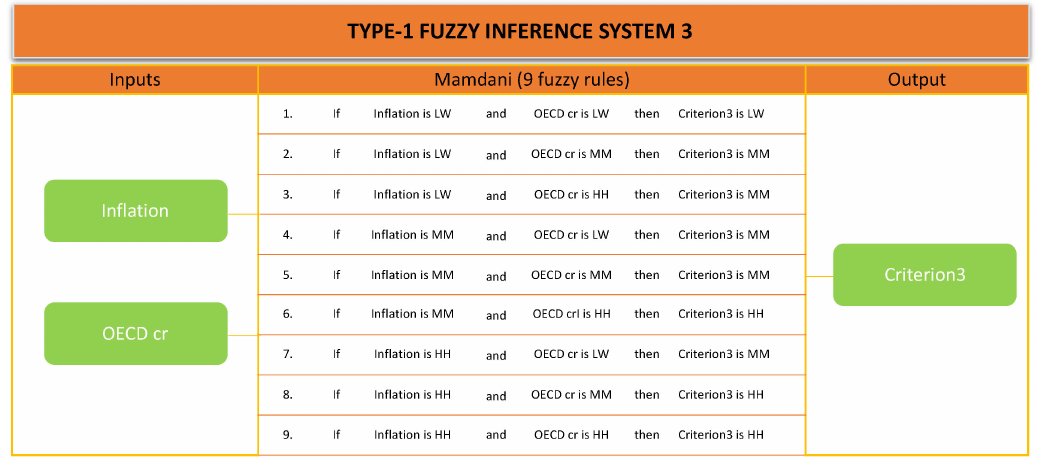
Figure 6. Second Type-1 fuzzy system GNI variables.